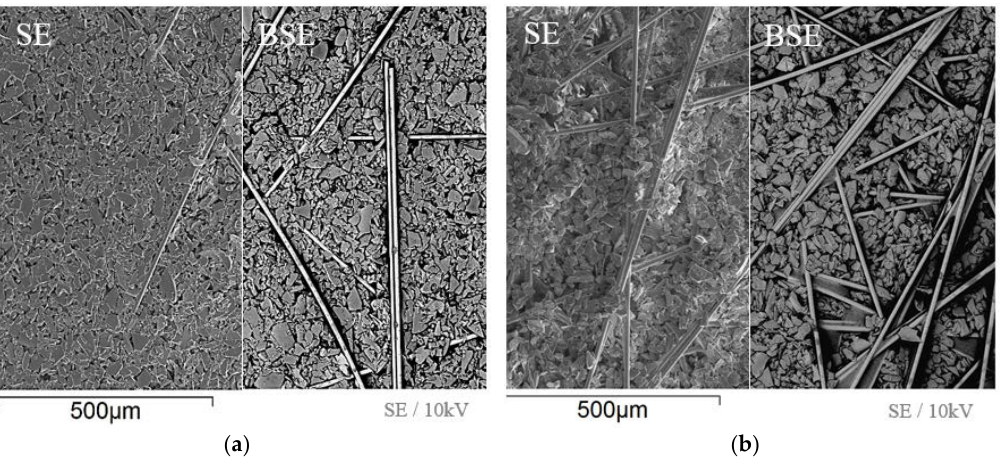
Figure 2. Scanning electron microscopy (SEM) images of a glass fiber nonwoven/glass platelet composite separator, ( a ) top view; ( b ) bottom